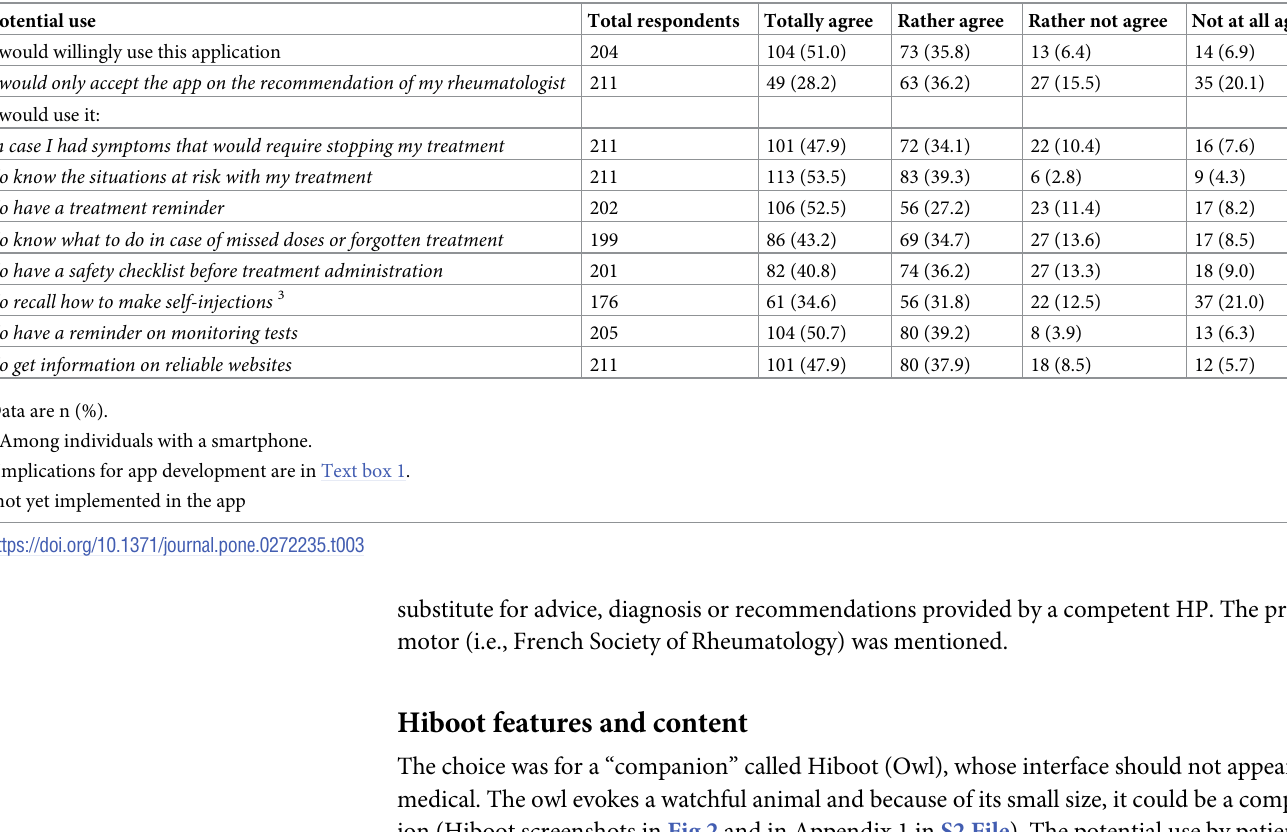
Table 3. Quantitative study: Potential use of the app, patients’ approval 1 , and implications for app development 2 ( in italics ) (n =